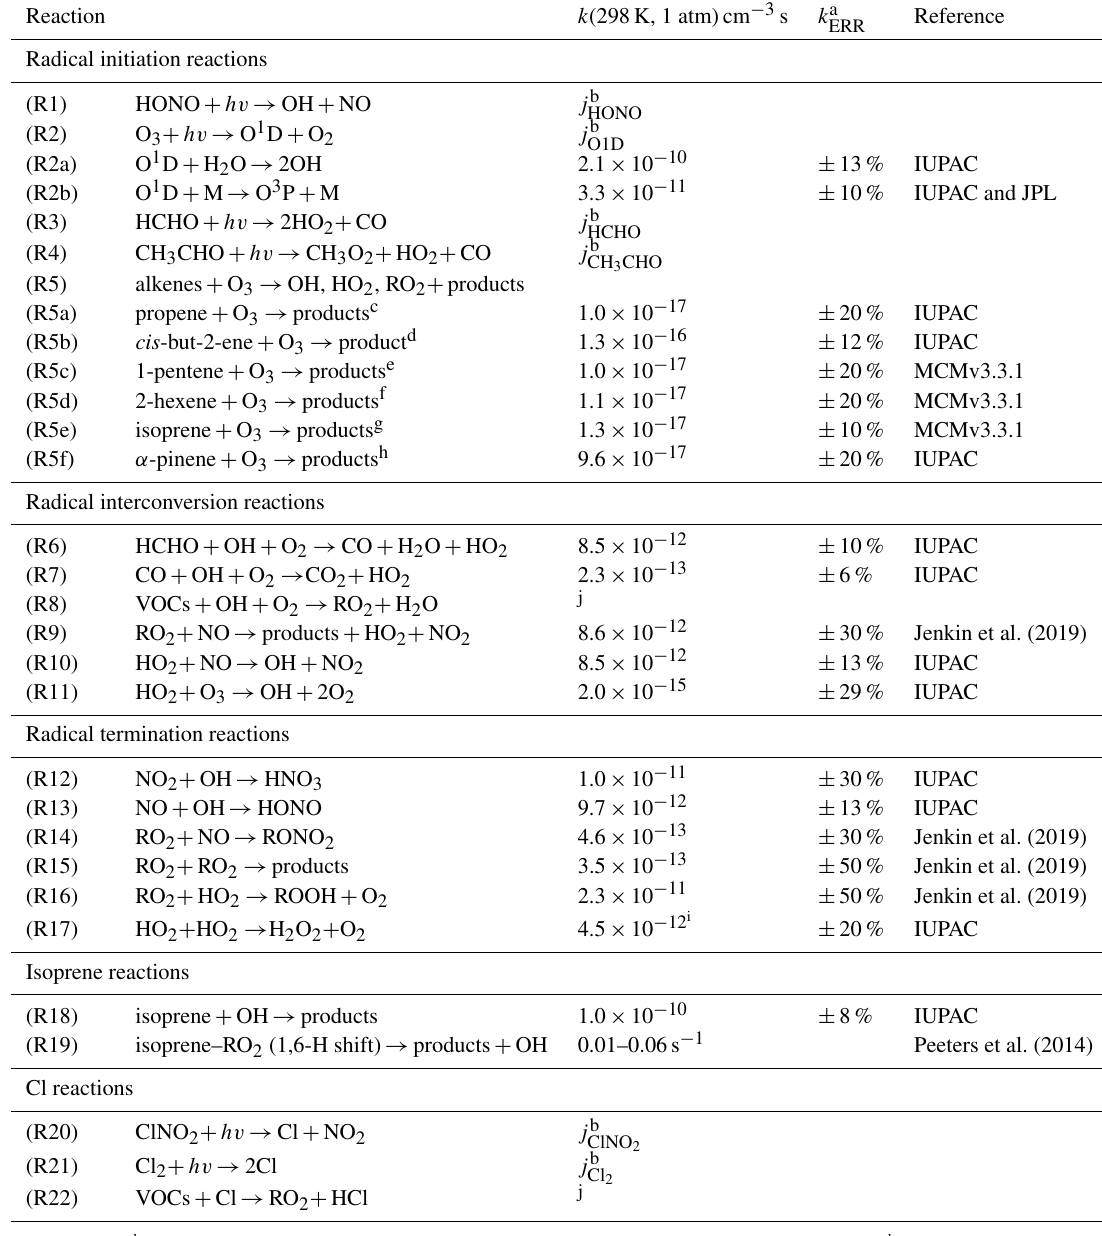
Table 1. Chemical reactions and rate constants used for the analysis of the chemical budgets of radicals. Values of reaction rate constants are given for standard conditions (298K, 1atm). Actual numbers are used for the